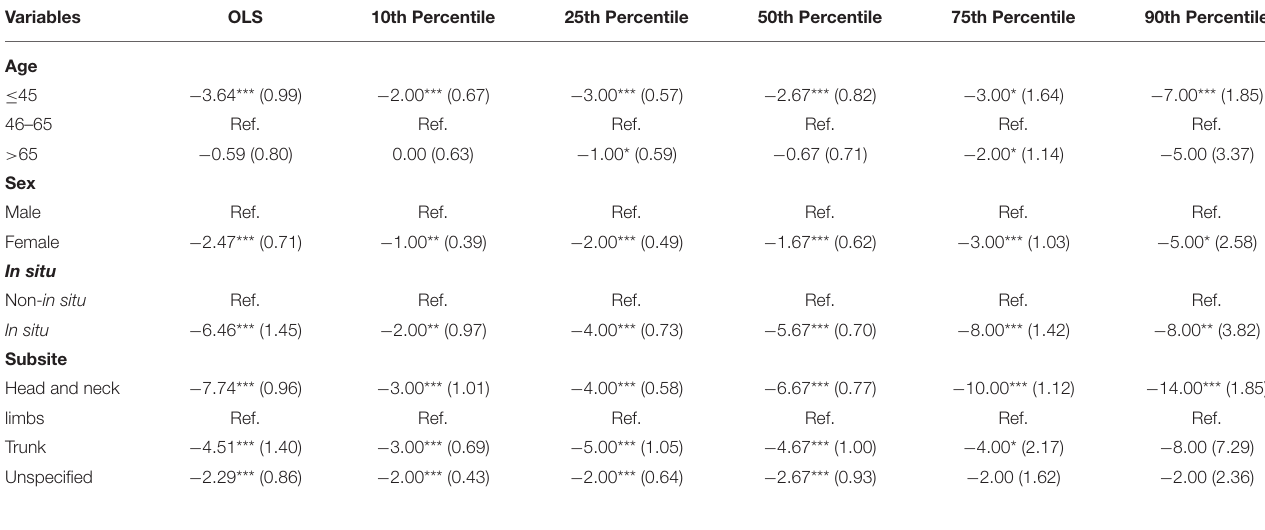
TABLE 4 | Quantile regression versus linear regression for LOS of patients with melanoma undergoing surgery in Hunan.